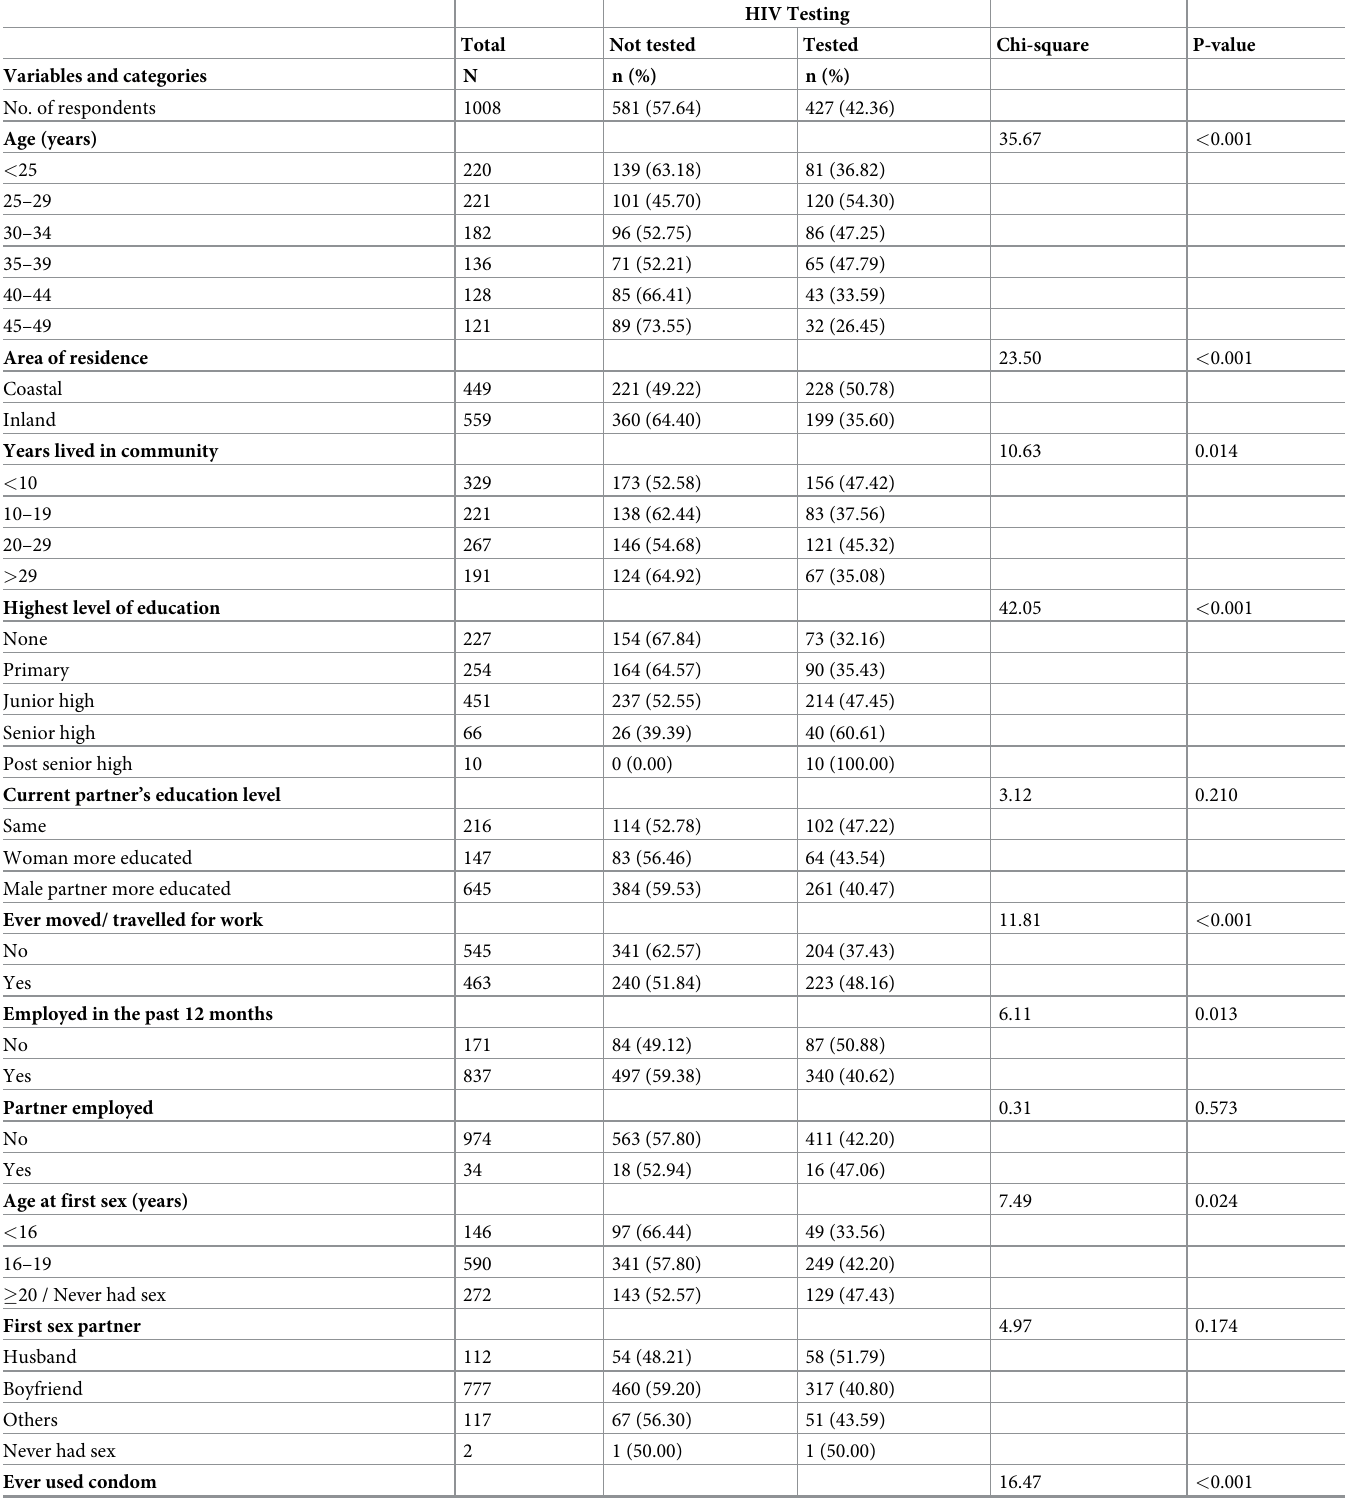
Table 2. Bivariate analysis of factors associated with HIV testing among